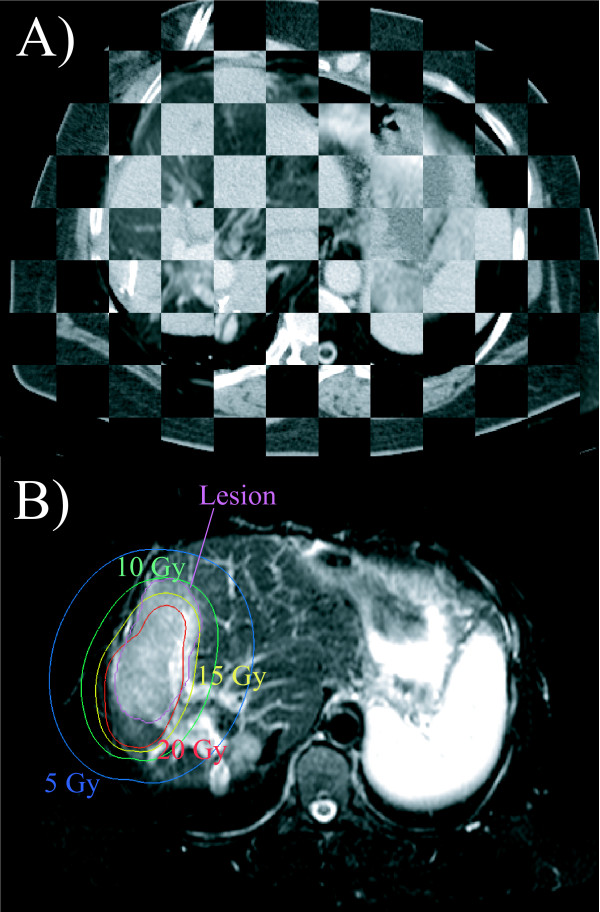
Image registration. A) T2-w image coregistered with the planning CT. Note that only the liver was coregistered and therefore good matching of the images was only achieved for the liver. B) T2-w image showing segmented lesion and isodoses at 12-week follow-up. A prononounced shift of the irradiation effect with respect to the planned dose distribution as shown in this example was typically not found.